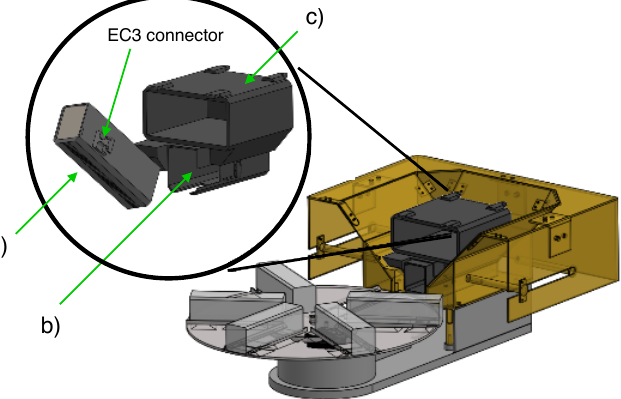
Figure 2. Battery coupling system: ( a ) holder, ( b ) receiver and ( c ) paylod. The battery holder consists of a rectangular housing of 4 mm thick walls, and it can contain a 48 × 44 × 164 mm battery or any other type with smaller dimensions. The main feature of the battery holder is an EC3 connector on its outside right wall. Another